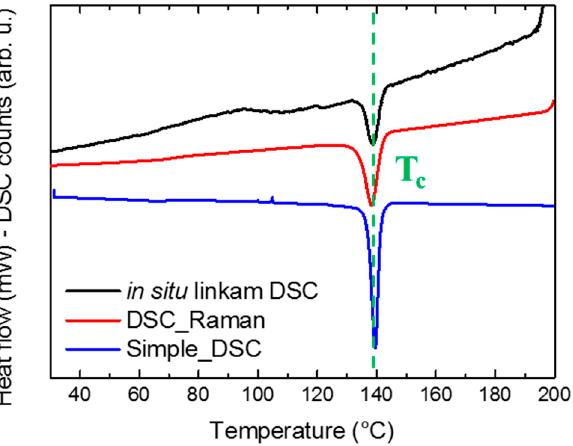
Figure 3. Comparison of the thermograms obtained by the Linkam DSC600 setup (X-rays and Raman laser on), the Q200 TA DSC-Raman setup (Figure S2A available in the supplementary material document) and a single Q200 TA DSC profile. Slight discrepancies in the crystallization temperature were observed, as well as a slight drift in the baseline.